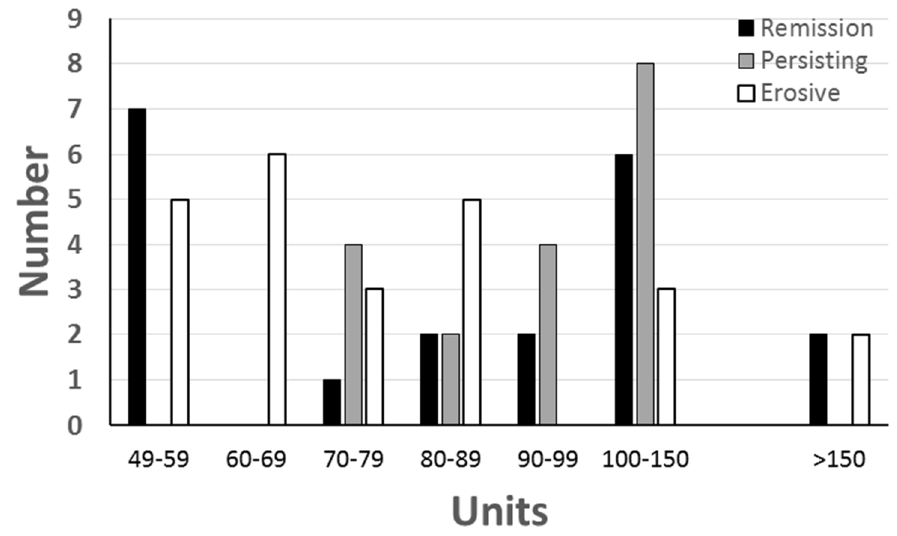
Figure 2. Distribution of levels of antibodies to CB10 at onset among 65 patients with early RA who had anti-CB10, grouped according to outcome—remission, persisting non-erosive arthritis or erosive arthritis.